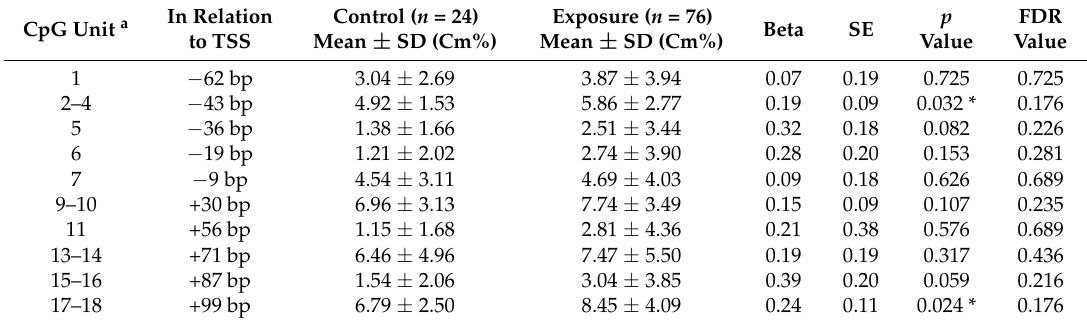
Table 1. Associations between benzene exposure and promoter DNA methylation in ERCC3